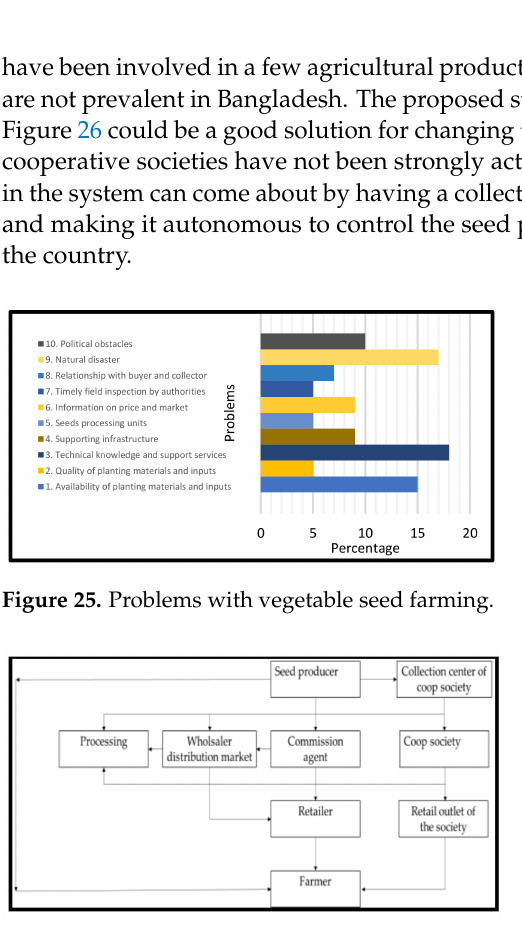
Figure 26. Proposed supply chain system for vegetable